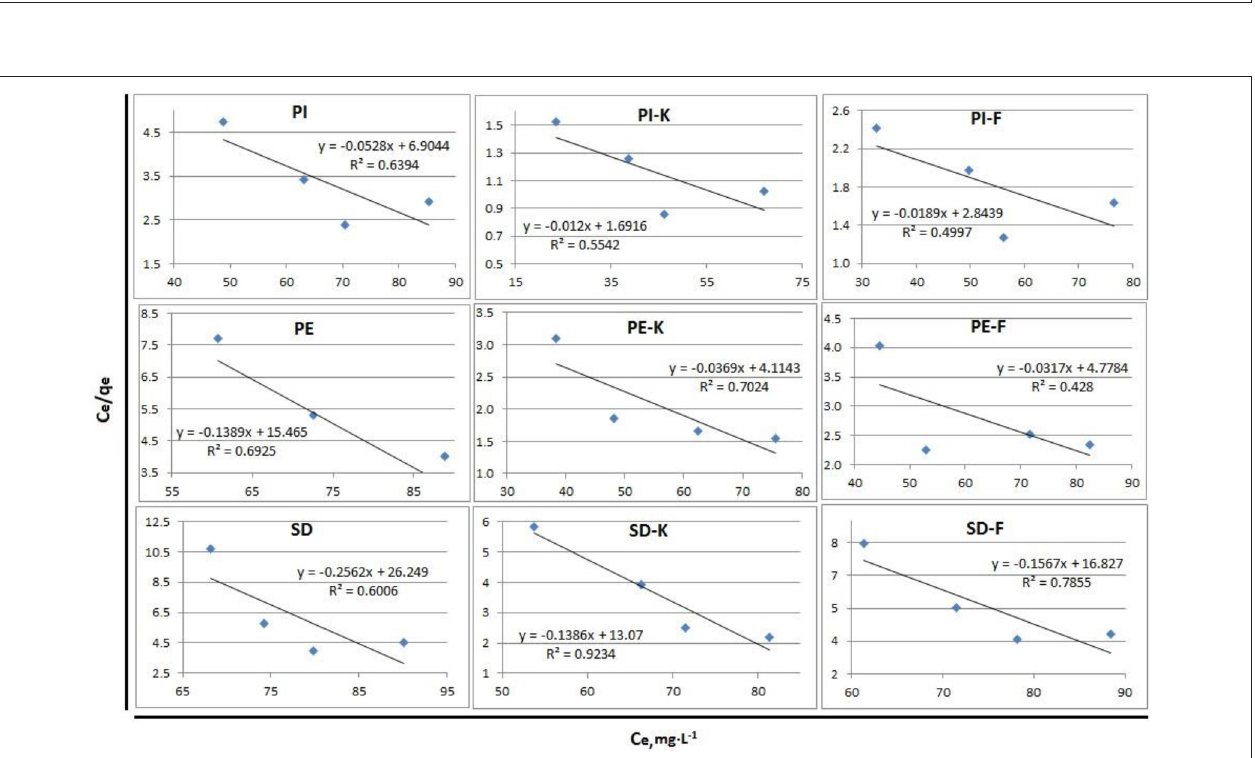
FIGURE 8 | Langmuir isotherms for phenols adsorption on biochars PI, PE, SD, and modified biochars PI-K, PE-K, SD-K or PI-F, PE-F, SD-F.